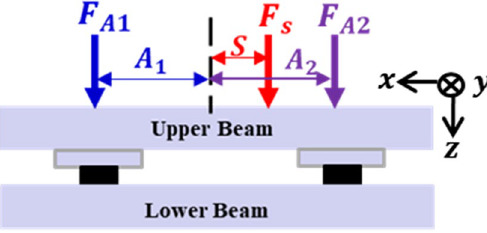
Figure 9. Free-body diagram for static analysis.